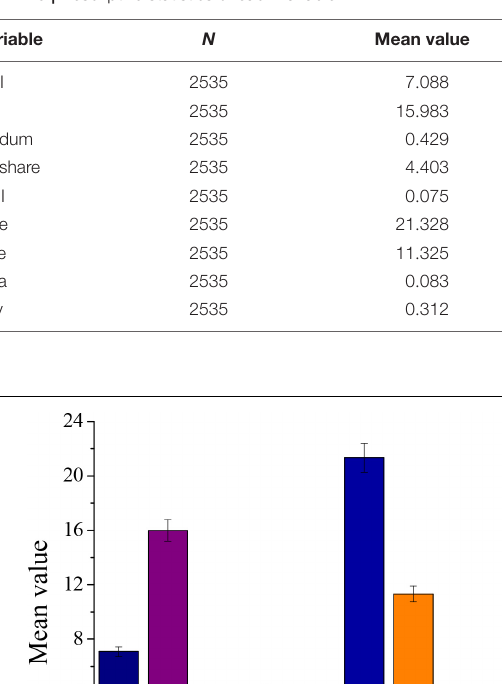
TABLE 3 | Descriptive statistics of each variable.